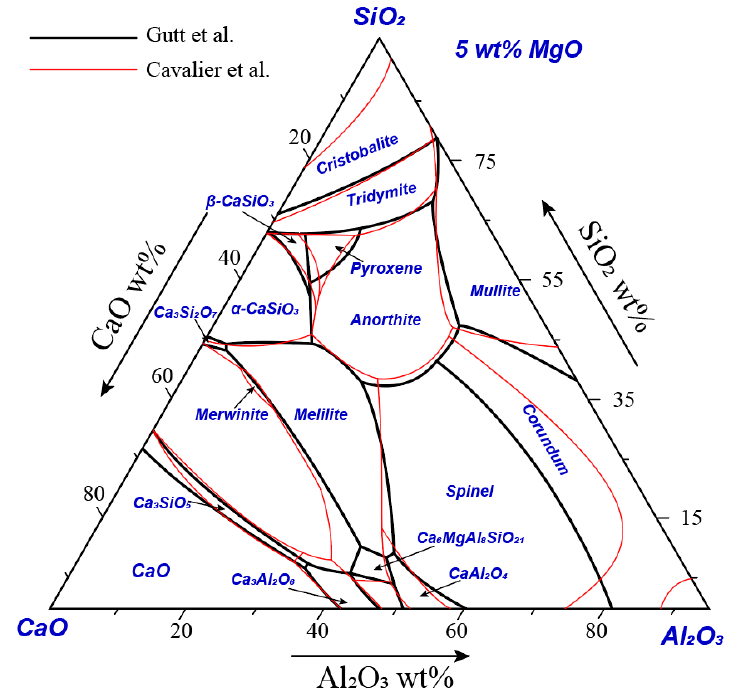
Figure 8. Comparison of the phase boundaries between Cavalier and Sandrea-Deudon [10] and Gutt and Russell [11].